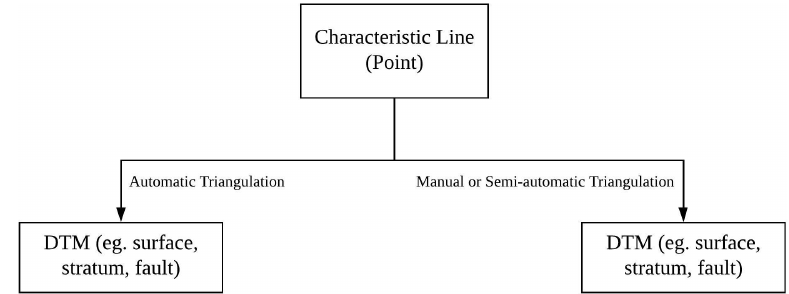
Figure 2: Flow chart of entity model